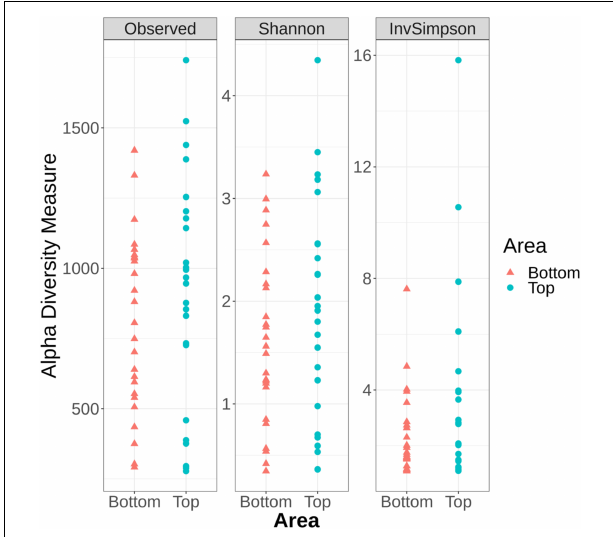
FIGURE 4 | Alpha diversity measures among the top and the bottom areas of the pig carcasses sampled using Observed, Shannon, and Inverse Simpson